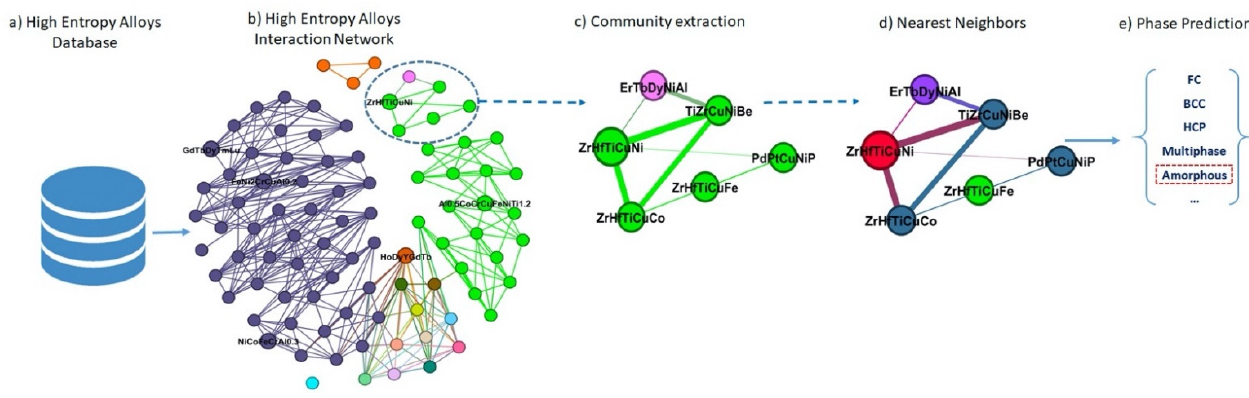
Figure 1. An example of the proposed method for phase prediction in HEAs. In Step ( a ), we extracted the related features/descriptors from the HEA database, and then ( b ) created an interaction network based on the similarities between HEAs. ( c ) In this examplem ZrHfTiCuNi alloy is considered as a phase prediction sample, hence related community of this HEAs is extracted from the interaction network. ( d ) The ZrHfTiCuNi has four neighbors; therefore, three of them were selected which are highlighted in dark blue if k is three. ( e ) Finally, phase can be predicted by voting on neighbors’ labels as Amorphous for ZrHfTiCuNi.